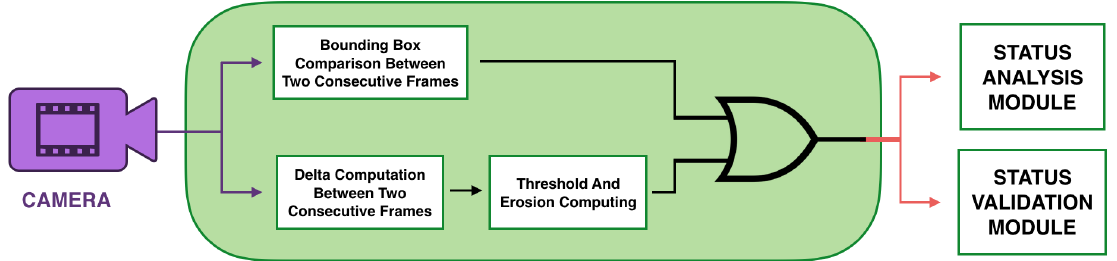
Figure 7. Motion detection